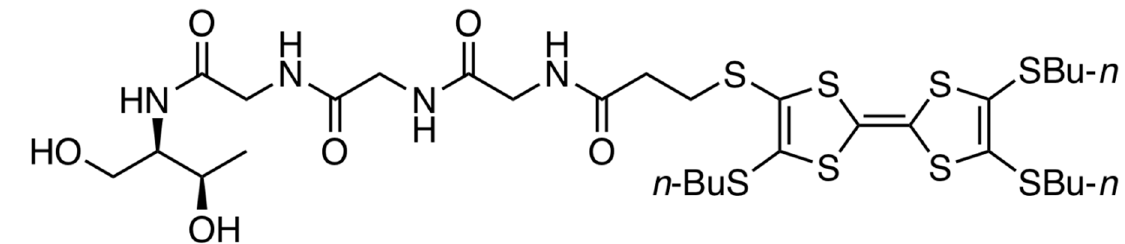
Figure 1. Chemical structure of tetrathiafulvalene (TTF)–triglycyl derivative studied in this work.